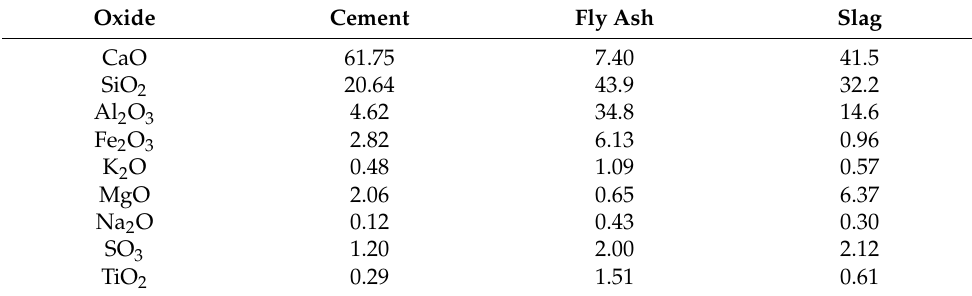
Table 1. Chemical composition of reference cement, fly ash, and slag (mass%). Oxide